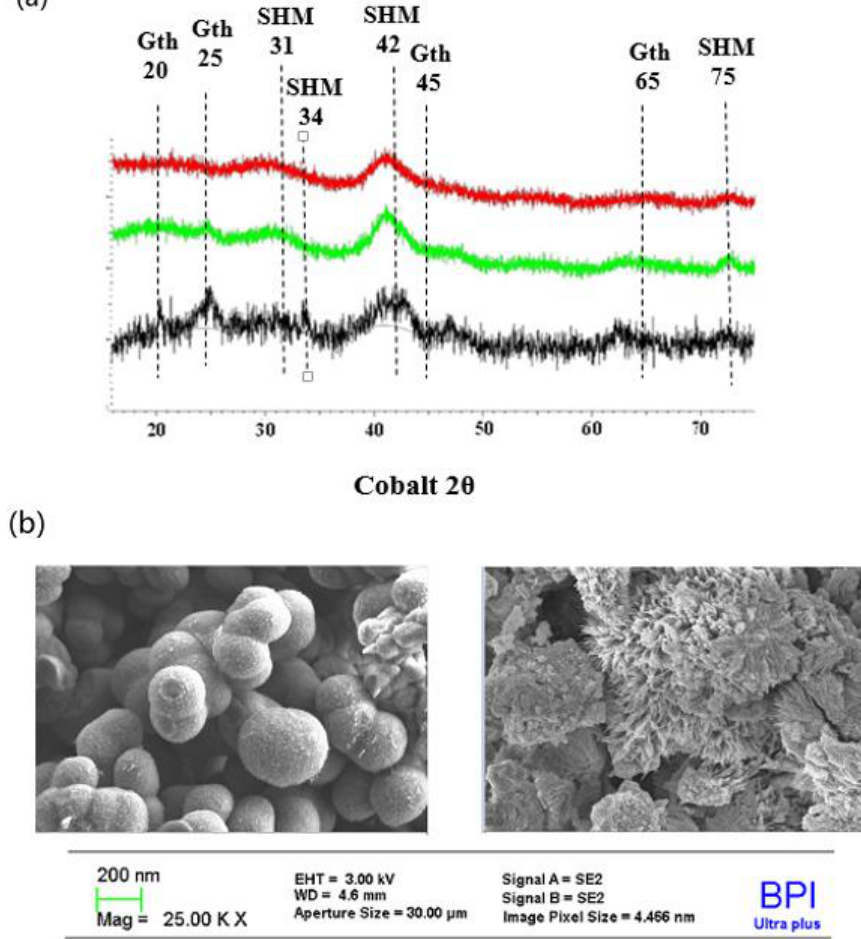
Figure 1. ( a ) X-Ray diffractograms of Biogenic synthesis SHM (SorbB, red), Oxidative synthesis SHM (SorbS, green) and High-pressure compaction SHM (SorbP, black); ( b ) SHM images for SorbS (left) and SorbP (right).